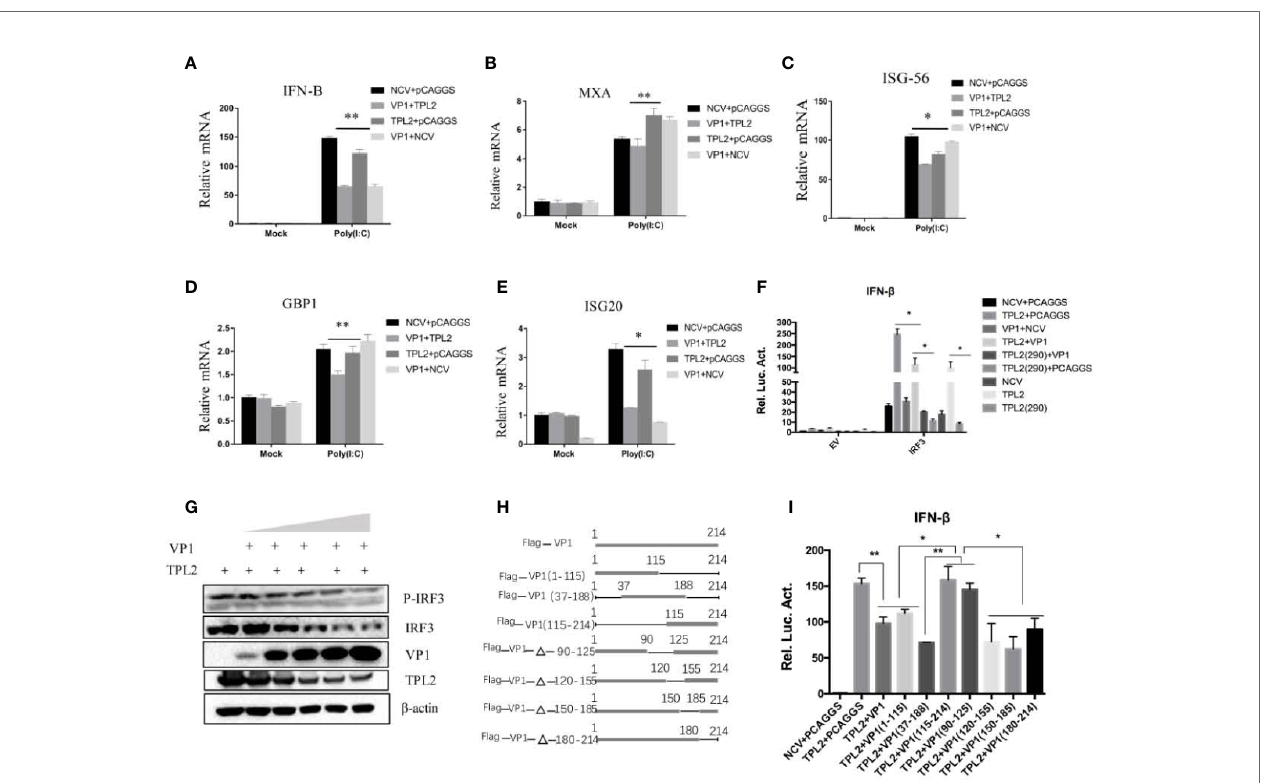
FIGURE 7 | VP1-mediated TPL2 inhibition of the IFN- b signaling pathway. (A – E) HEK293T cells were transfected with expression plasmids encoding Flag-VP1, and Myc-TPL2 followed dual-luciferase assay. Quantitative RT-PCR was used to evaluate the expression of genes encoding IFN- b , MXA, ISG-56, GBP1, and ISG-20. (F) HEK293T cells were transfected with expression plasmids encoding Flag-VP1, Myc-TPL2, TPL2 (290), and IRF3 and detected using the dual-luciferase reporting system. Each dataset is the result of three or more independent experiments. (G) HEK293T cells were transfected with 0, 0.5, 1, 2, 4, or 8 m g of the Flag-VP1 expression plasmid with 0.5 m g TPL2 expression plasmid. After 24 h, cells were collected, and the lysate was probed with anti-IRF3, anti-P-IRF3, anti-Myc, and anti- Flag-VP1 by Western blotting (WB). (H) Schematic diagram of VP1 truncated mutants. (I) HEK293T cells were transfected with plasmids encoding Myc or Myc-TPL2 and plasmids expressing Flag-VP1 or Flag-VP1-truncation products. 24 h later, IFN- b was measured by luciferase